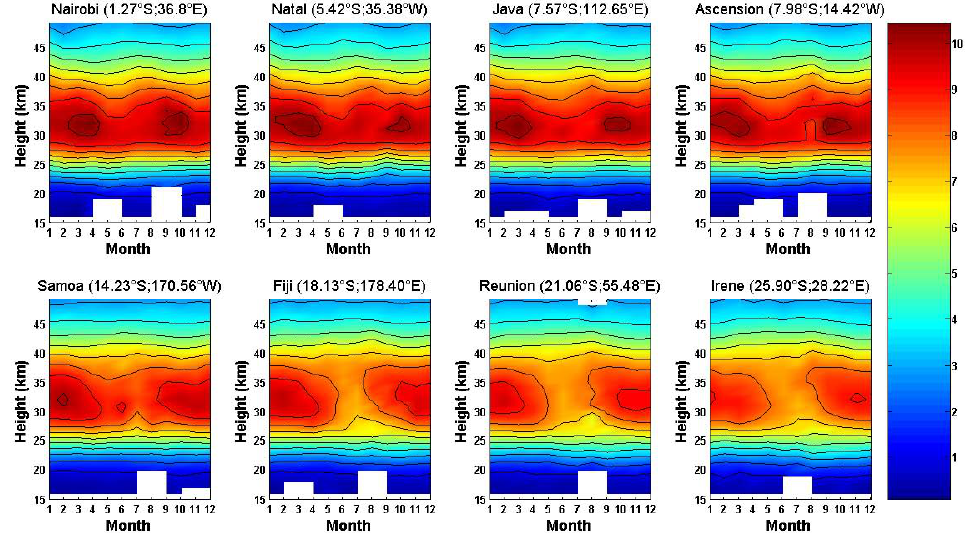
Fig. 3. Monthly median distributions of ozone mixing ratio (in ppmv) as derived from GOMOS observations per station. The contours are separated by 1ppm.